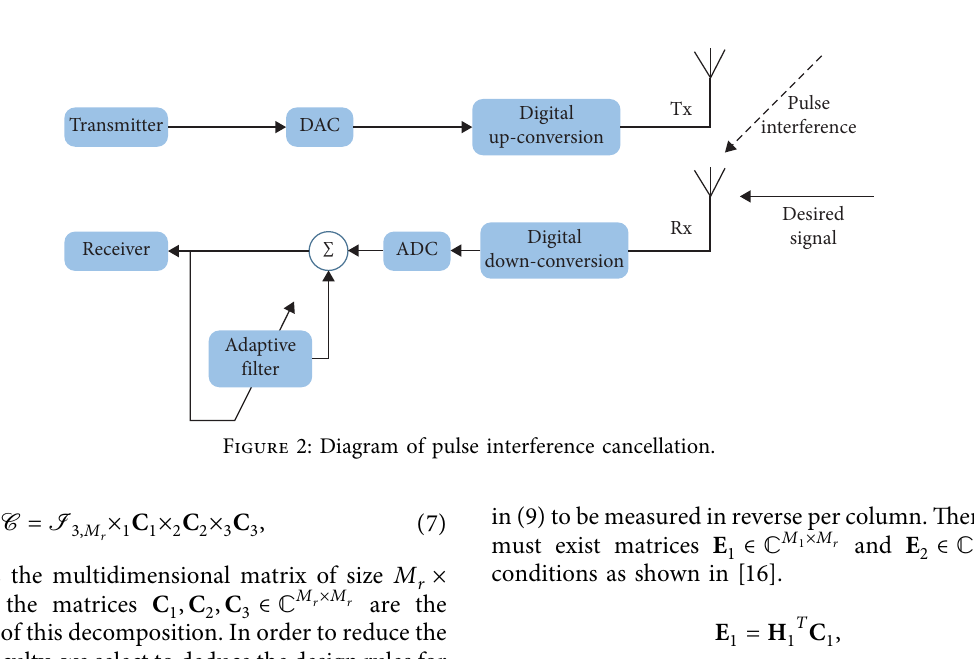
Figure 1: A UAV-aided PIC system.